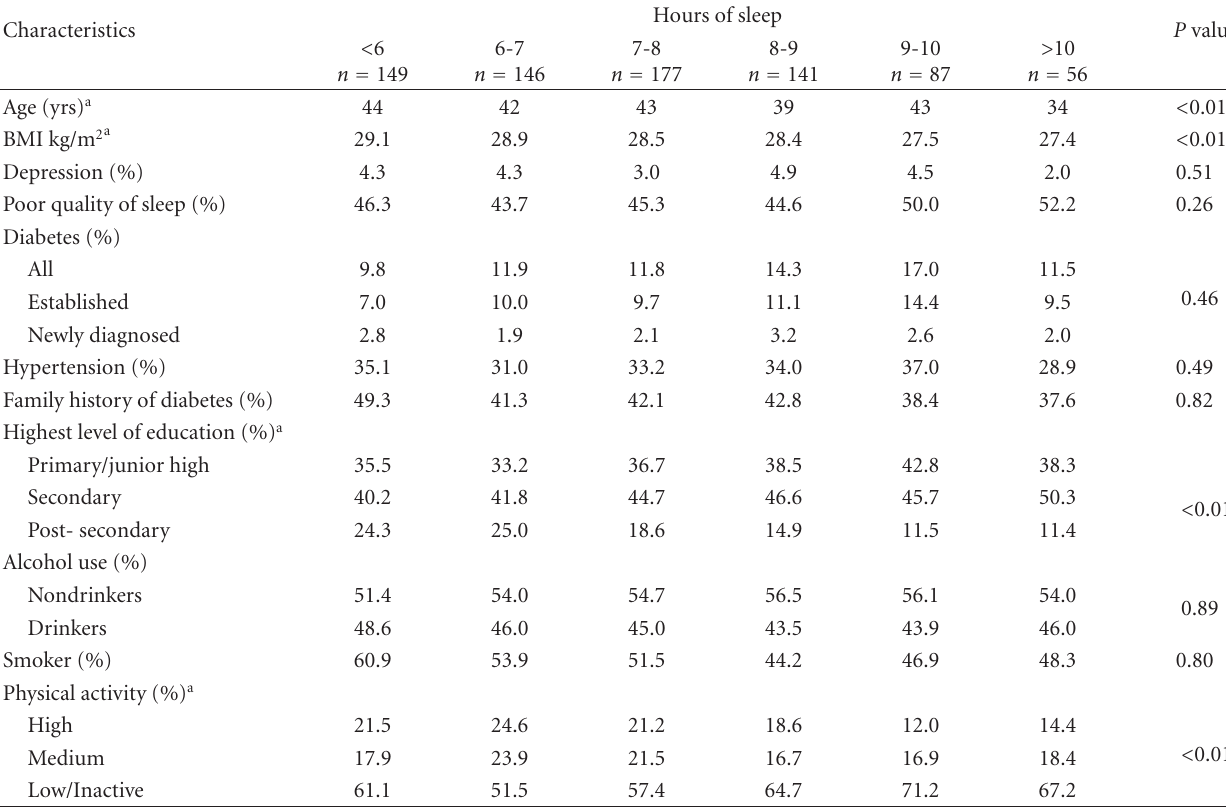
Table 3: Demographic, anthropometric, lifestyle factor and chronic disease prevalence, with self-reported hours of sleep in Jamaican women. Characteristics